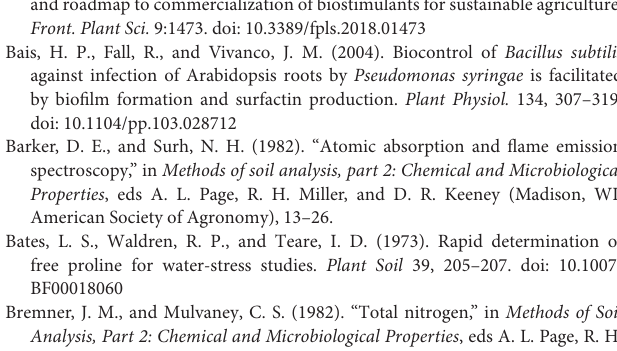
Supplementary Figure 1 | Production of auxins by different rhizobacterial strains. Initially each rhizobacterium was grown in LB broth supplemented with 0.2% of L-tryptophan in agitating condition. After 48 h incubation, 1 mL culture was collected and centrifuged. Then 500 µ L supernatant was mixed with 1 mL of Salkowski reagent. Development of pink color indicated positive for auxin related compounds including IAA production. Supplementary Figure 2 | Expression of nifH gene in different rhizobacterial strains. Primer pairs of Ueda19F and Ueda19R amplified 389 bp, while 310 pb was amplified by KAD3-F and DVV-R primer pairs. (A) Lane 1- ESR3, Lane 2- ESR4, Lane 3- ESR6, Lane 4- ESR7, Lane 5- ESR9, Lane 6- 1 kb + ladder, Lane-7 ESD3, Lane-8 ESD8, Lane-9 ESD16 23, Lane-10 ESD21, Lane-10 ESB9, Lane-12 Negative control; Lane 1 to 5 used KAD3-F and DVV-R primers pair and